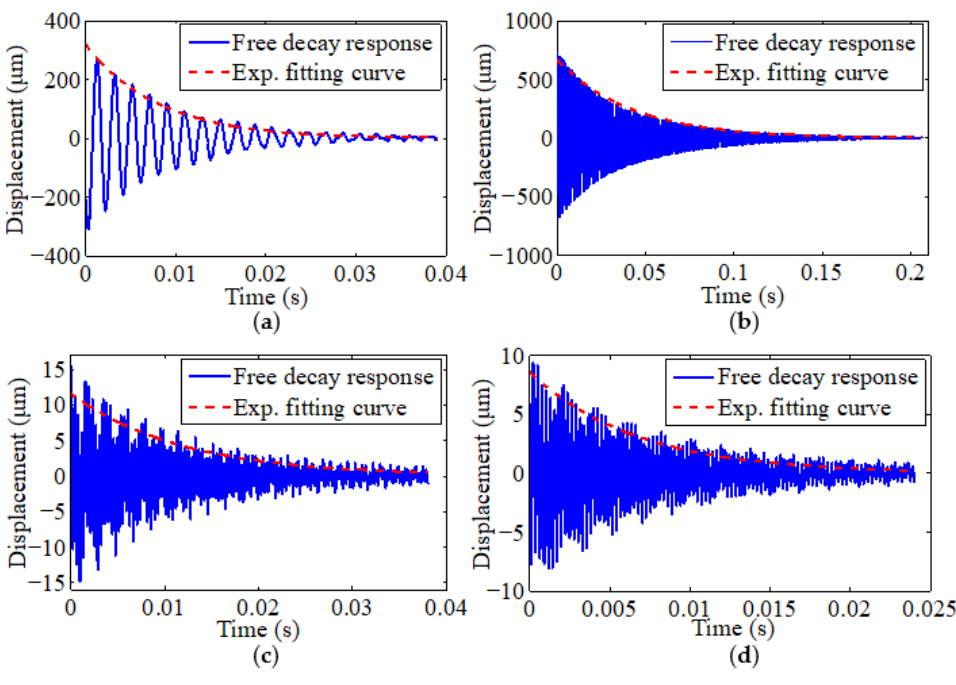
Table 4. Identified resonance frequencies and modal damping ratios of armature assembly with and without MF.